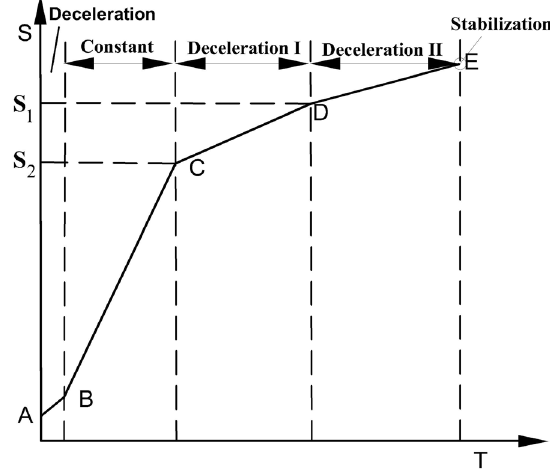
Fig. 14 Schematic of the slope creep evolution